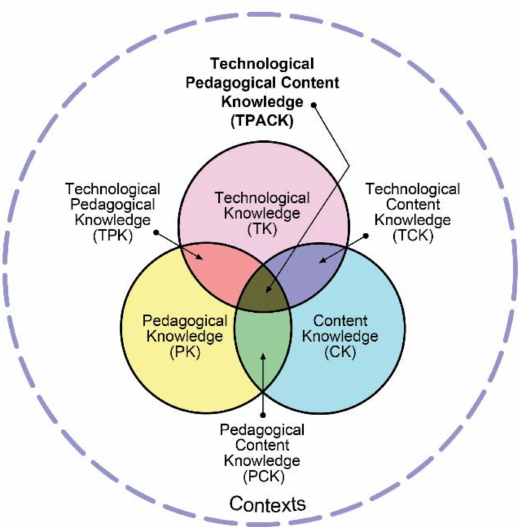
Figure 1. TPACK framework and its knowledge components. The TPACK Image (rights free, from http://www.tpack.org/ (accessed on 15 February